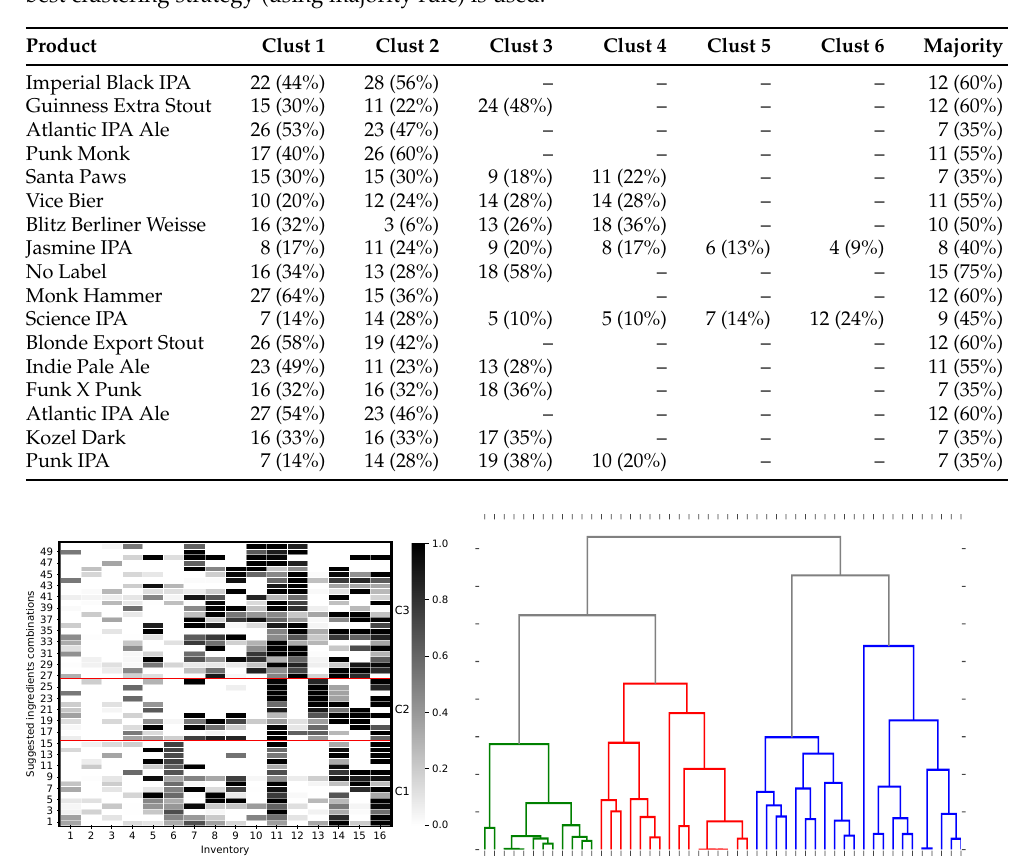
Figure 7. Left : Ordered solutions for Guinness Extra Stout based on clusters, C 1 , C 2 , C 3 , with C 1 : 1–15, C 2 : 16–26, and C 3 : 27–50). Right : Dendrogram of the clusters where colours green, red, and blue represent the aforementioned